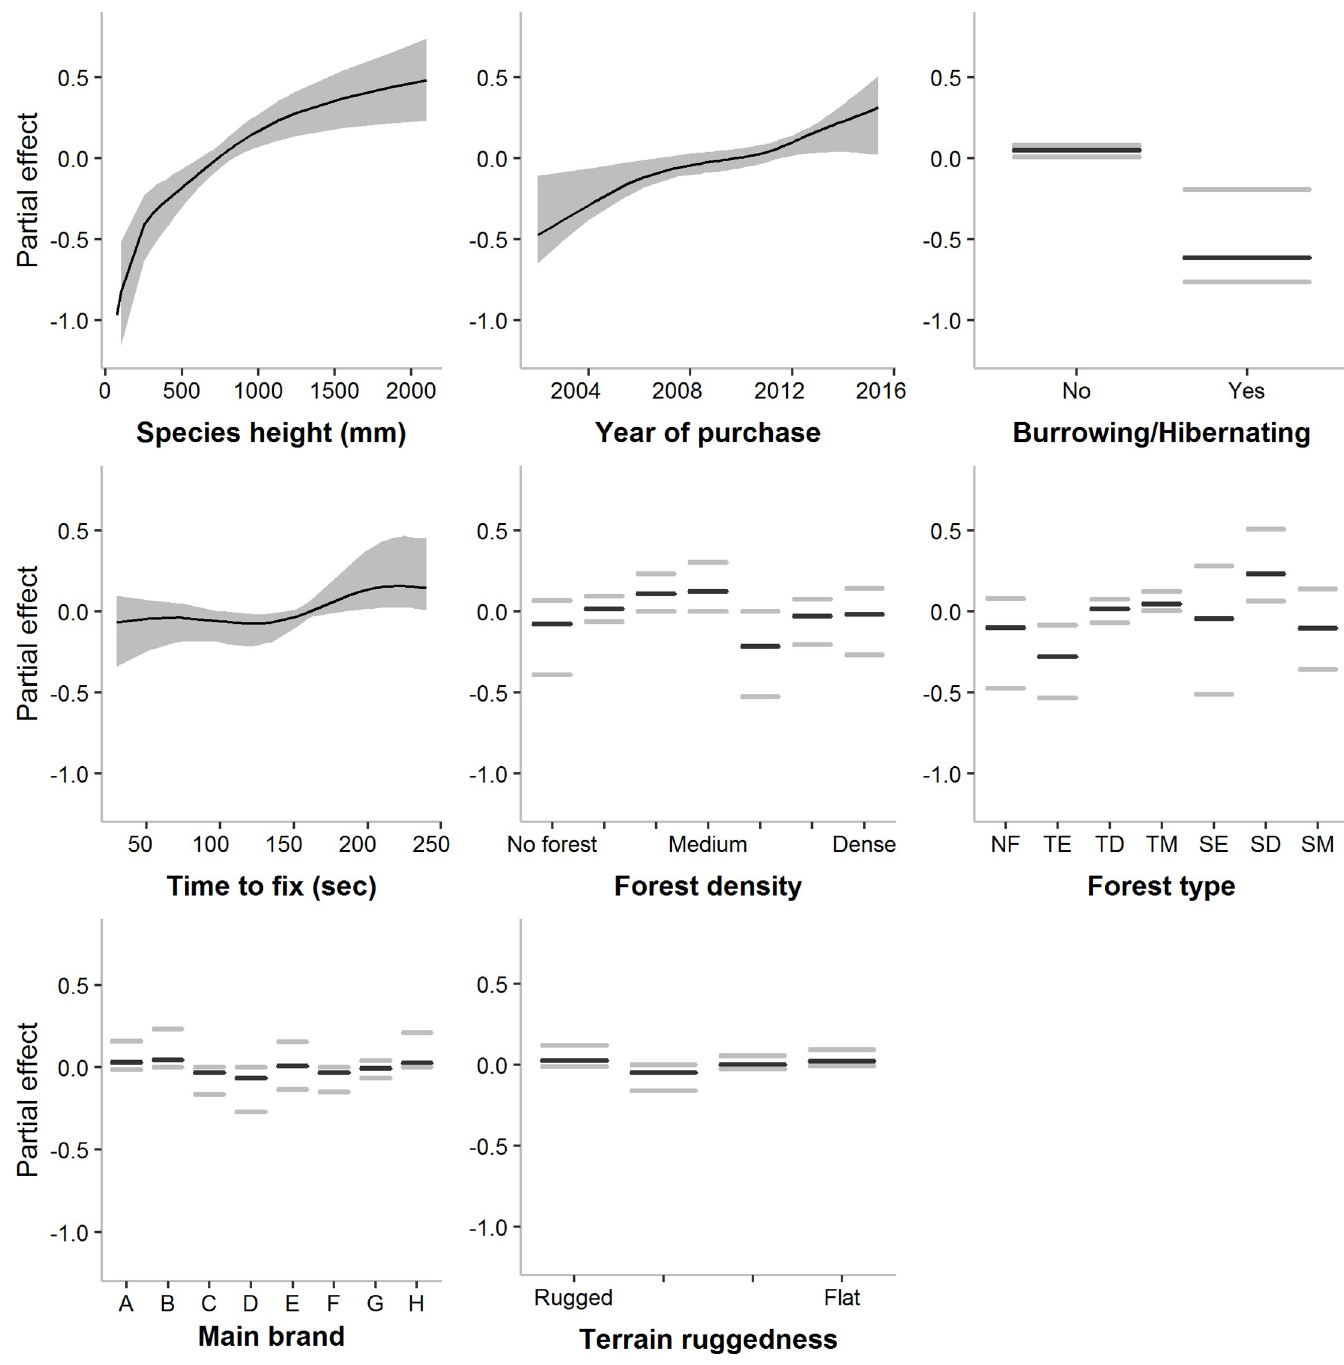
Fig 3. Covariate partial effects on the mean Fix acquisition rate. Mean-centered partial effects of the most important variables predicting the mean ( μ ) fix acquisition rate of satellite telemetry units (empirical confidence intervals in grey). Graphs are presented left-to-right in order of importance. Partial effects display the effect of the variable while accounting for all other variables in the model. Forest type levels: NF = No forest cover; TE = Temperate evergreen; TD = Temperate deciduous; TM = Temperate mixed; SE = (Sub)Tropical evergreen; SD = (Sub)Tropical deciduous; SM = (Sub)Tropical